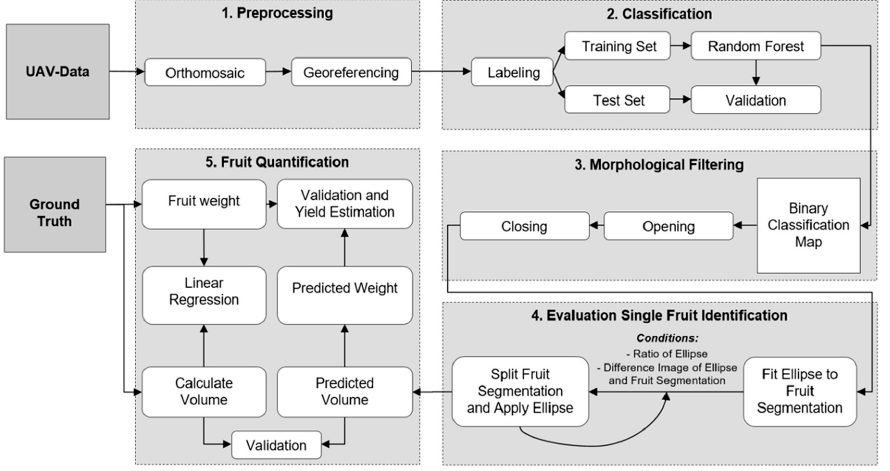
Figure 3. Workflow of the proposed methodology.